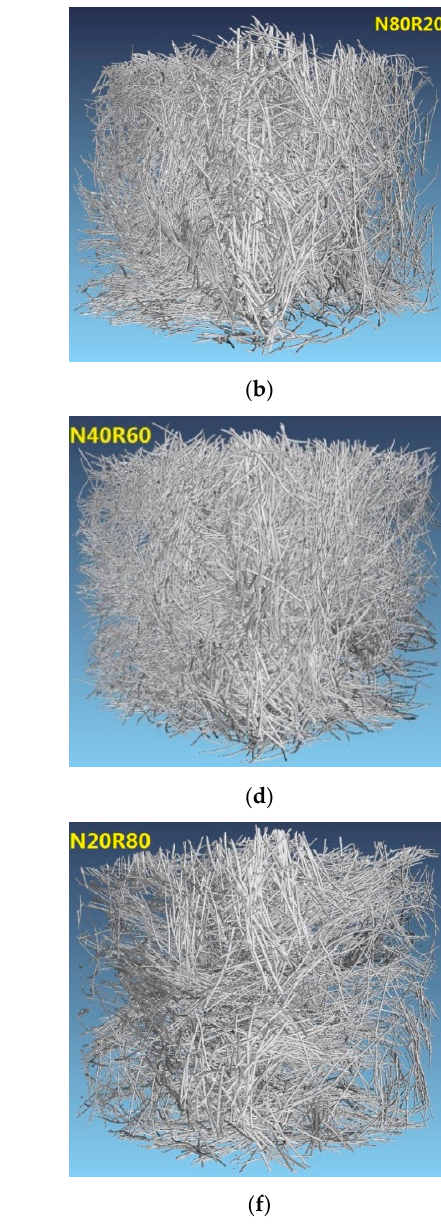
Figure 12. Pores and steel fibres distribution of UHPC by X-CT. ( a ) Pores distribution of N80R20; ( b ) Steel fibres distribution of N80R20; ( c ) Pores distribution of N40R60; ( d ) Steel fibres distribution of N40R60; ( e ) Pores distribution of N20R80; ( f ) Steel fibres distribution of N20R80.